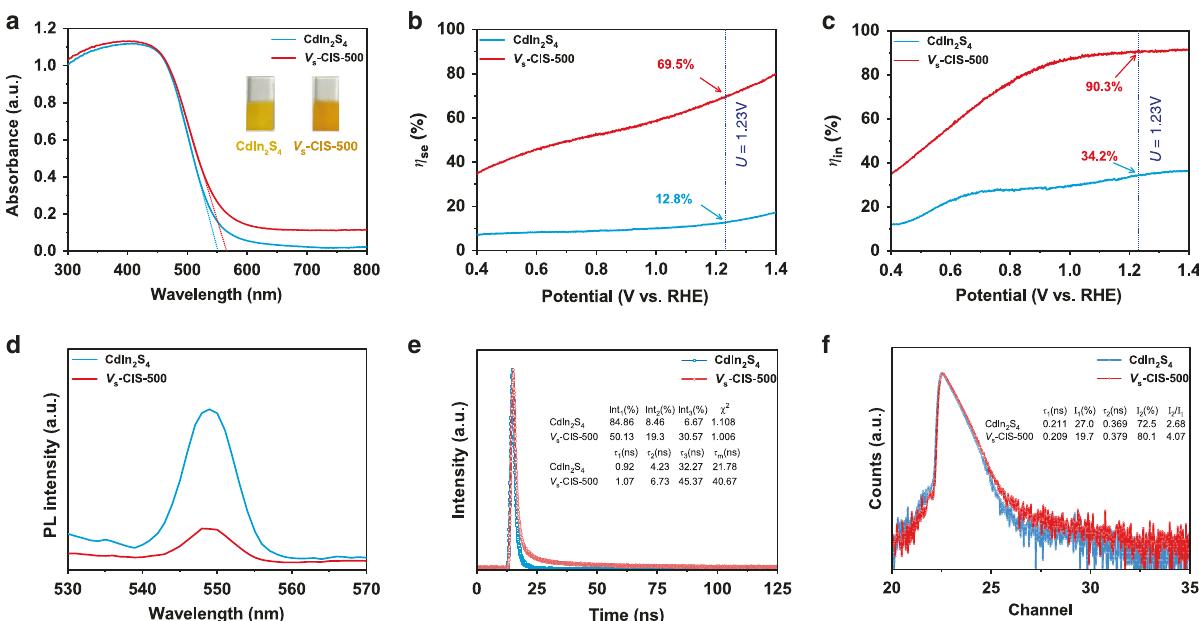
Fig. 3 Optical and photoelectrochemical characterizations. a UV – vis diffuse re fl ectance spectra. b Charge separation ef fi ciency and c charge injection ef fi ciency vs. potential curves. d Steady-state PL spectra with excitation wavelength λ ex = 370 nm. e Time-resolved transient PL decay spectra with excitation wavelength λ ex = 370 nm. Inset is the fi tted results according to a tri-exponential model, I t ð Þ ¼ intensity, the lifetime, and the amplitude of the i th component, respectively. f PALS of CdIn 2 S 4 and V s -CIS-500. Inset is the fi tted results according to